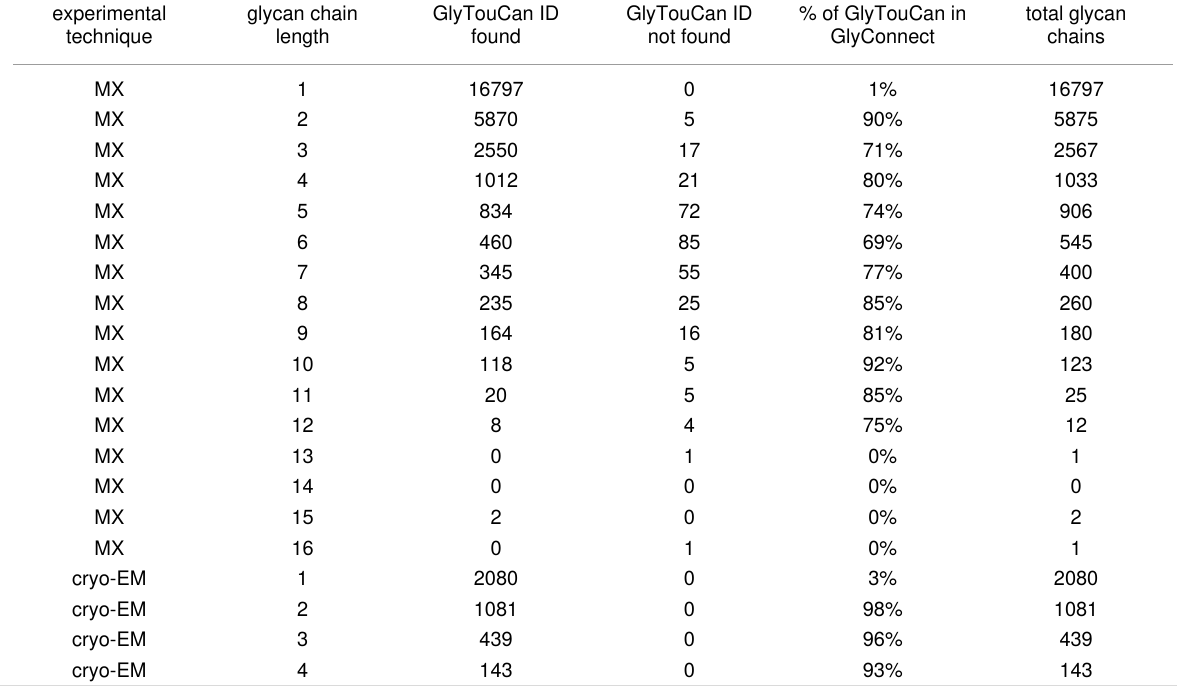
Table 2: Comparison of the successful glycan matches detected by Privateer in the GlyTouCan and the GlyConnect database. a experimental